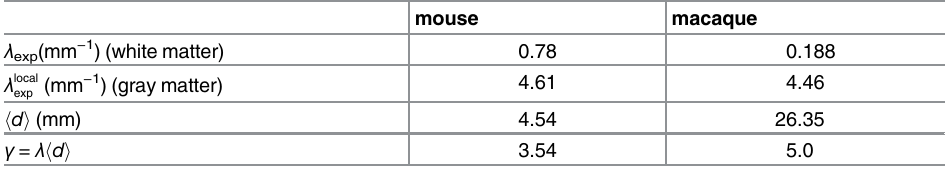
Table 1. Summary of EDR parameters in the mouse and